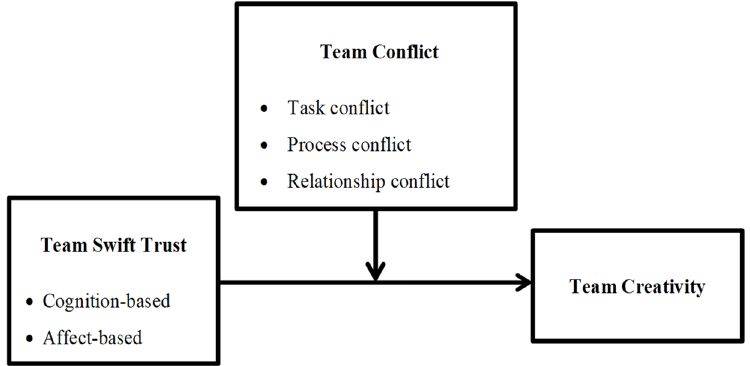
Figure 1 . hypothesized moderating effect model by team conflict variables. Figure 1. Hypothesized moderating effect model by team conflict